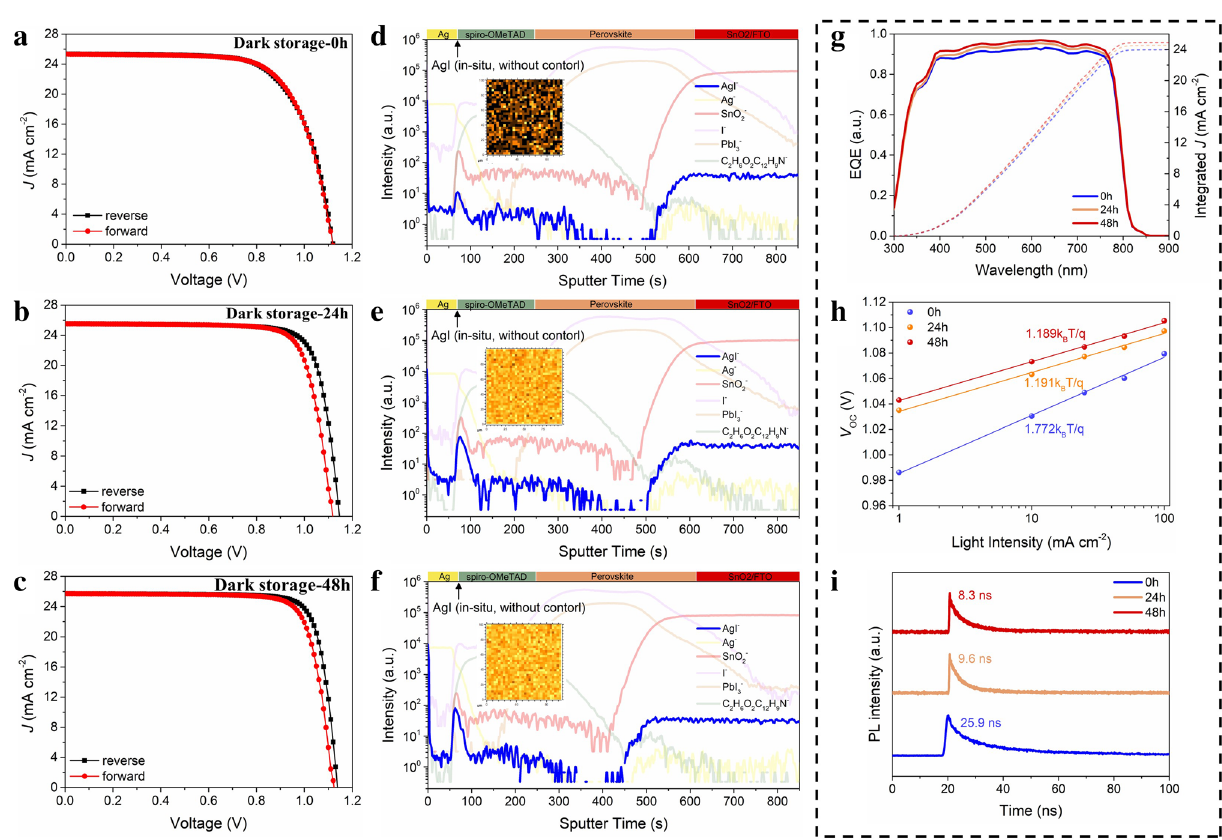
Fig. 1 In situ formation of AgI tunneling layer and its effects on device performances. a – c J–V curves of the champion regular Ag-PSC and d – f the depth profiles of ToF–SIMS (Inset: 2D elemental mapping of AgI −. signal at Ag/spiro-OMeTAD interface) after being stored for 0, 24 and 48 h. g The IPCE and h ideality factor of the corresponding devices. i The evolution of TRPL for glass/SnO 2 /(FA,MA)PbI 3 perovskite/spiro- OMeTAD/Ag sample. Notes all devices in the figure were stored under dark and dry environment (< 10%